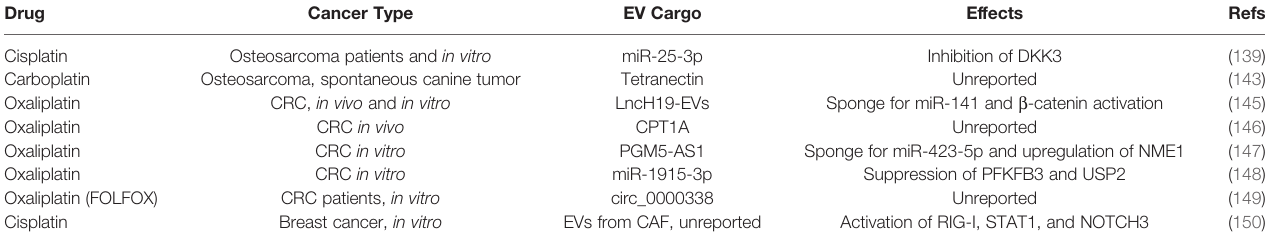
TABLE 1 | Resistance to platins mediated by EVs.